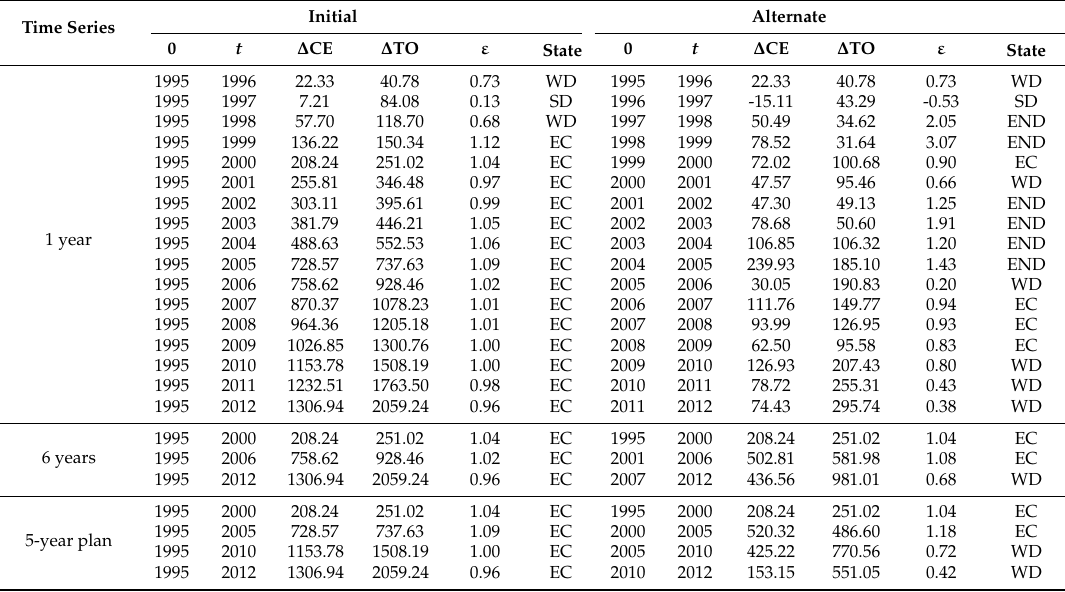
Table 1. The elasticity values and states of CE in multiple time scales and output of transport sector in